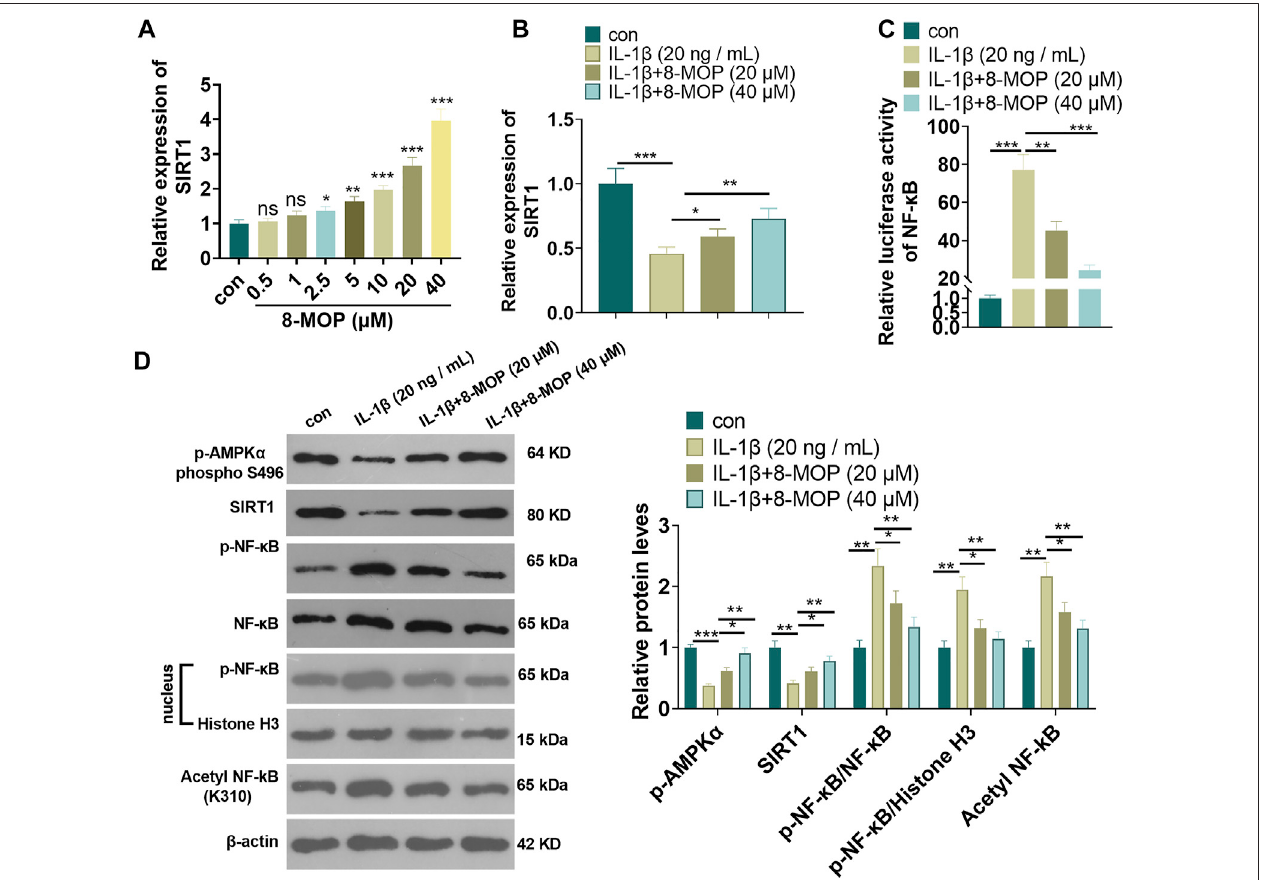
FIGURE 3 | 8-MOP enhanced SIRT1 and suppressed the phosphorylation of NF- κ B. A. Different doses of 8-MOP (0, 0.5, 1, 2.5, 5, 10, 20, 40 µM) were used for treating chondrocytes for 24 h qRT-PCR was used for evaluating SIRT1 mRNA. Rat chondrocytes were treated with IL-1 β (20 ng/ml) and/or 8-MOP (20 and 40 µM) for 24 h. (B) . qRT-PCR was used for evaluating SIRT1 mRNA. (C) . Dual luciferase experiment was used for evaluating the activity of NF- κ B. (D) . The expression of p-AMPK α , SIRT1 and p-NF- κ B p65 protein levels and acetylation NF- κ B p65 was determined by Western blot, respectively. ns p > 0.05, * p < 0.05, ** p < 0.01, *** p < 0.001. ( n (cid:1)